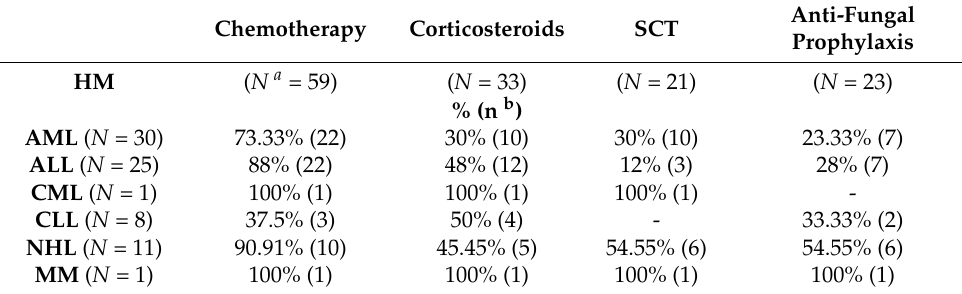
Table 4. Risk factors for disease per HM patient